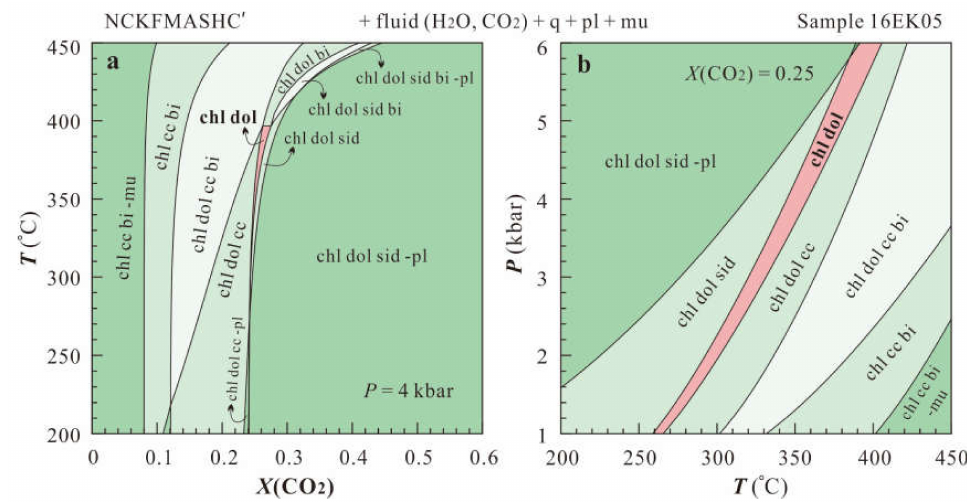
Figure 5. T – X (CO 2 ) ( a ) and P – T ( b ) pseudosections calculated for the dolomite-bearing chlorite schist. They are shaded with increasing color depth for the fields of increasing degrees of freedom. The observed mineral assemblage in the sample is highlighted. X (CO 2 ) = CO 2 /(H 2 O + CO 2 ) in moles. q: quartz; pl: plagioclase; mu: muscovite; chl: chlorite; dol: dolomite; sid: siderite; cc: calcite; bi: